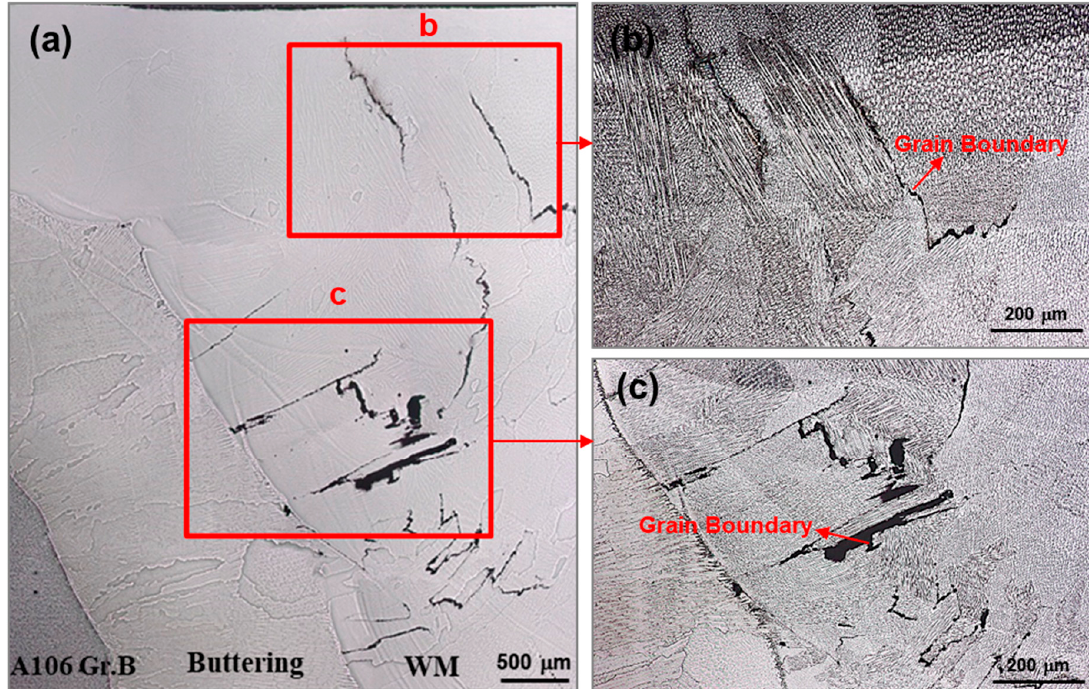
Figure 3. ( a ) A combined picture with several optical microscope (OM) pictures showing cracks formed between the buttering and the WM; ( b ), ( c ) SEM micrographs of the area marked with rectangular box .